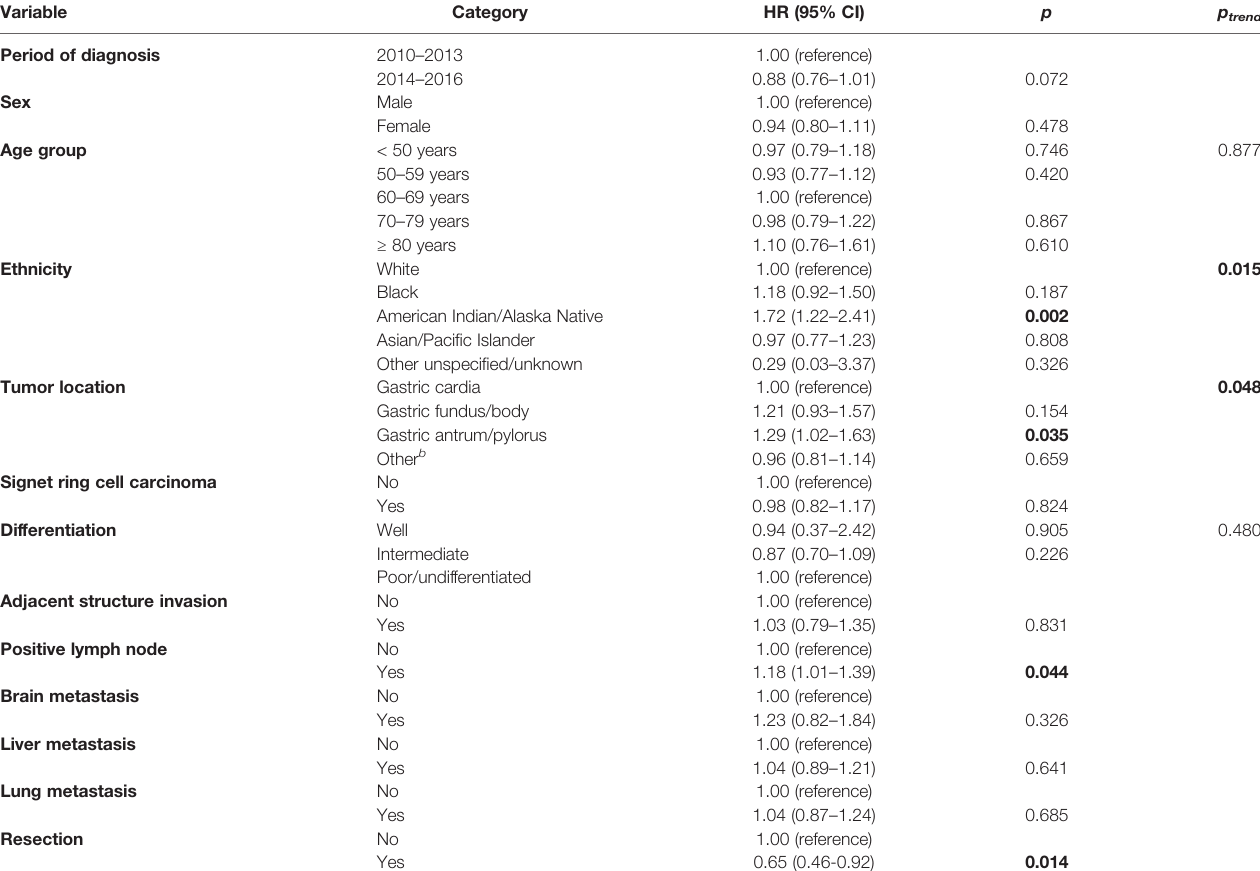
a Hazard ratios and 95% con fi dence intervals for the variables listed in the fi rst column except tumor differentiation were calculated using the Fine – Gray subdistribution hazard model mutually adjusted for these variables. For tumor differentiation, adjacent structure invasion, and positive lymph node with missing values, the association was assessed by additionally including these variables one by one into the above multivariable-adjusted model. Statistically signi fi cant p values are highlighted in bold. b Lesser curvature, greater curvature, overlapping lesion of stomach, and stomach (not otherwise speci fi ed). HR, hazard ratio; CI, con fi dence interval; NE, not estimable due to small case